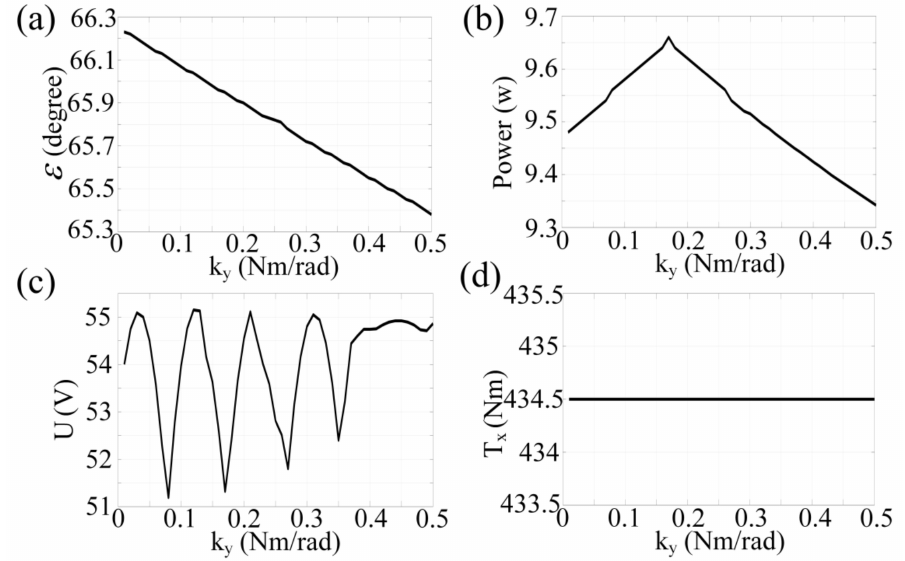
Figure 8. The effect of stiffness coefficient: ( a ) flywheel precession angular displacement; ( b ) output power; ( c ) voltage; ( d ) torque in x